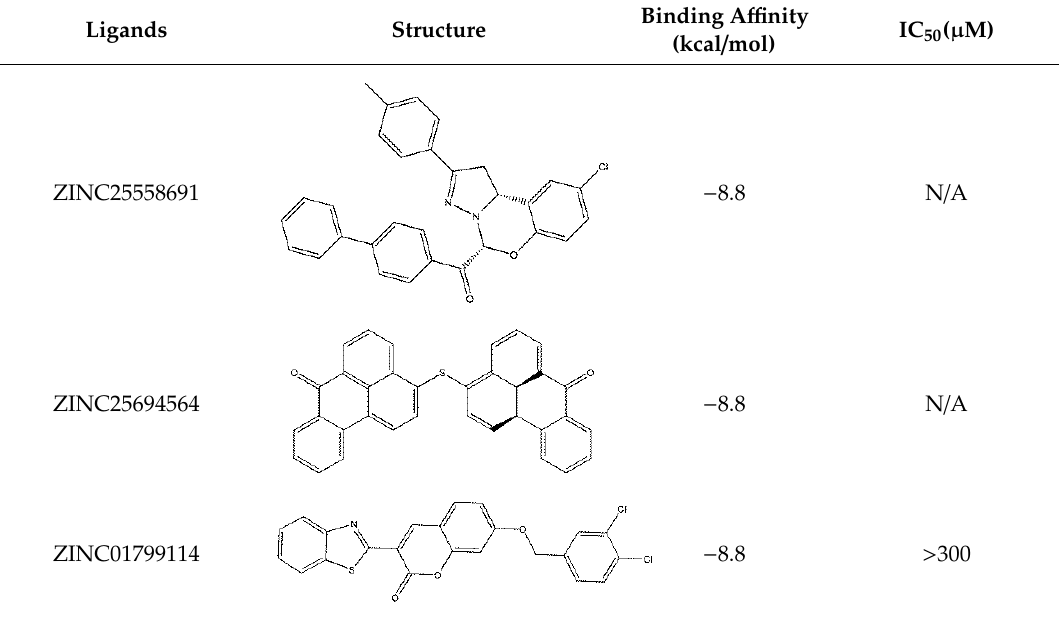
Table 2. MIC and FICI of meropenem in combination with ZINC05683641 against E. coli BL21 (pET28a-SP-NDM-1).